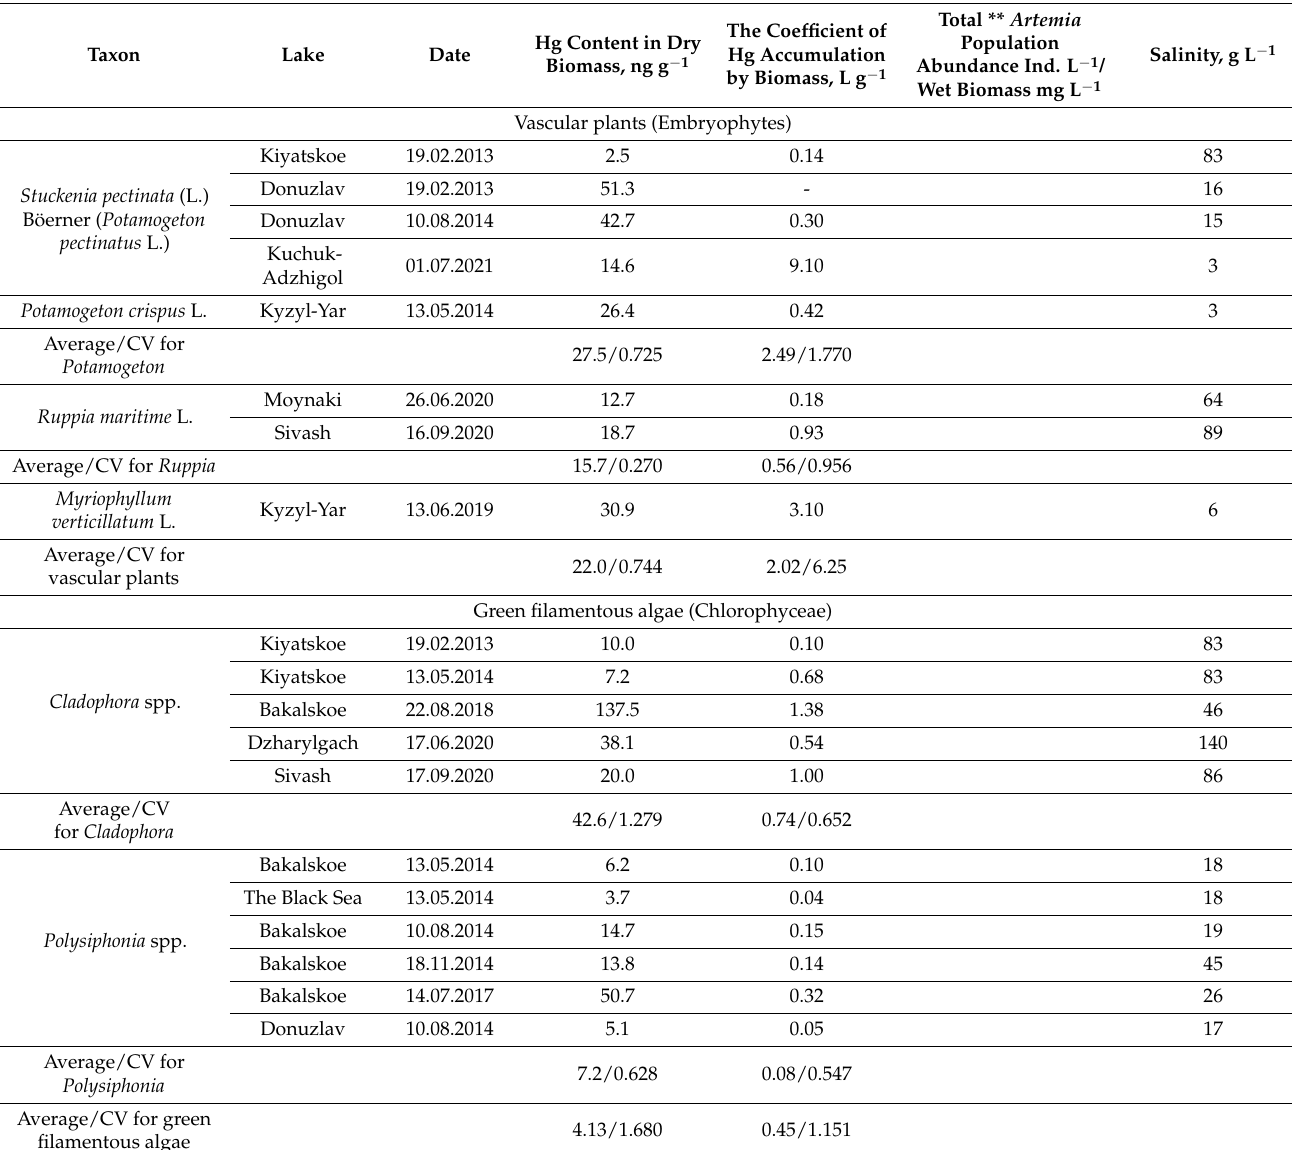
Table 4. The concentration of Hg in hydrobiont biomass in the Crimean saline lakes